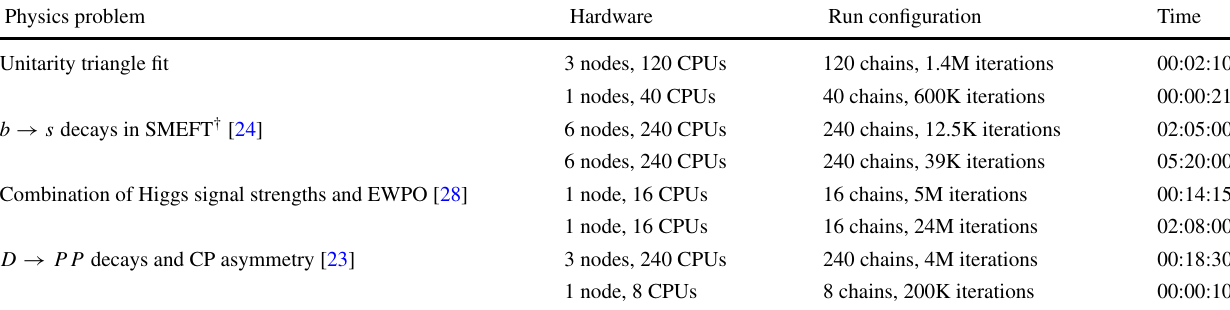
b → s analysis is done with factorized priors, hence the number of iterations should be multiplied by the number of parameters ( ∼ 50) to get a comparative estimate with the other cases. All runs performed in the BIRD or Maxwell clusters at DESY,